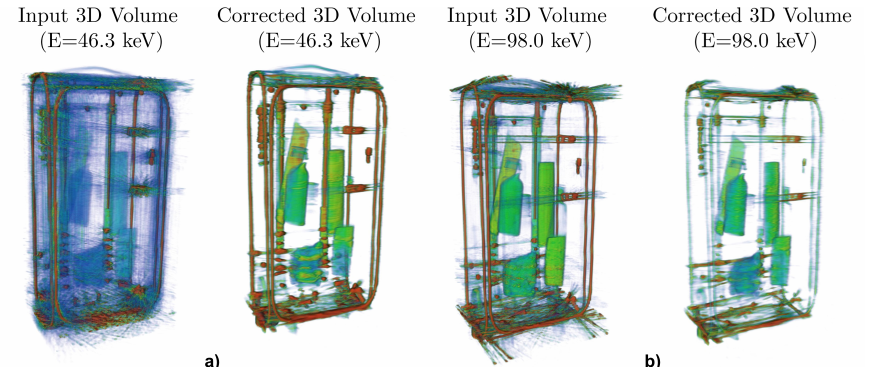
Figure 9. Input and MAR corrected 3D volume reconstruction of the suitcase at 46.3 keV in ( a ) and at 98.0 keV in ( b ). The CNN correction clearly reduces most of the artifacts increasing dramatically the quality of the